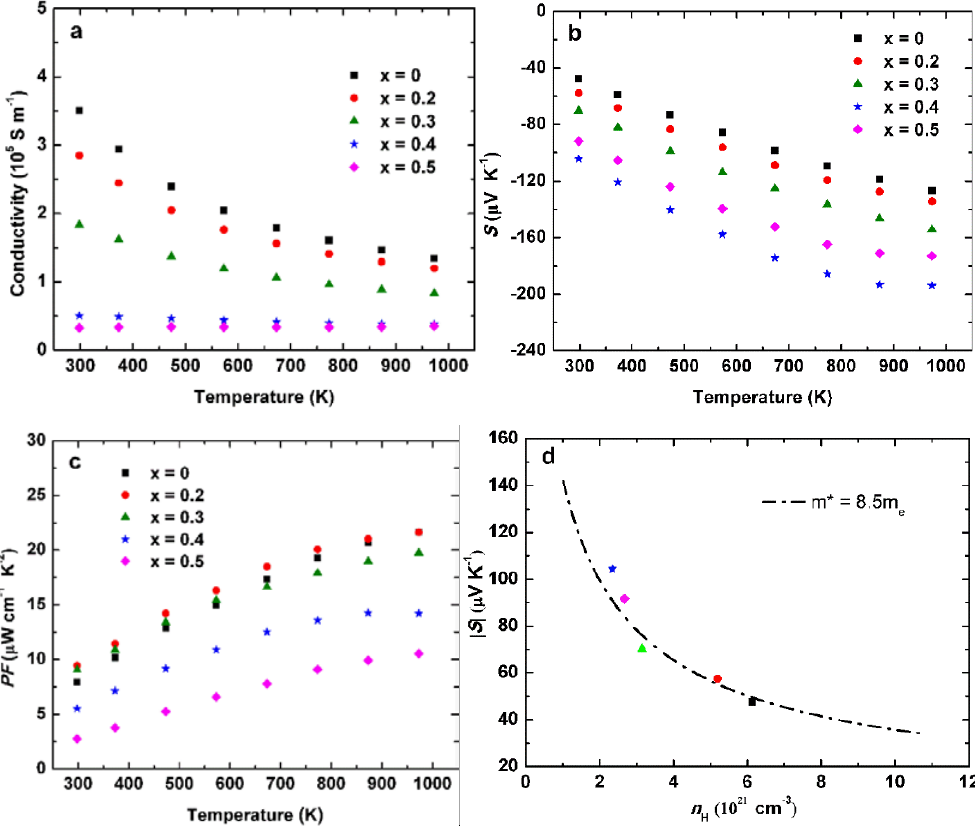
Figure 3. ( a ) Temperature-dependent electrical conductivity; ( b ) Seebeck coefficient; ( c ) power factor; and ( d ) and Pisarenko plot for NbCo 1+ x Sb. Table 2. Hall coefficient, carrier concentration, Hall mobility, effective mass, and deformation